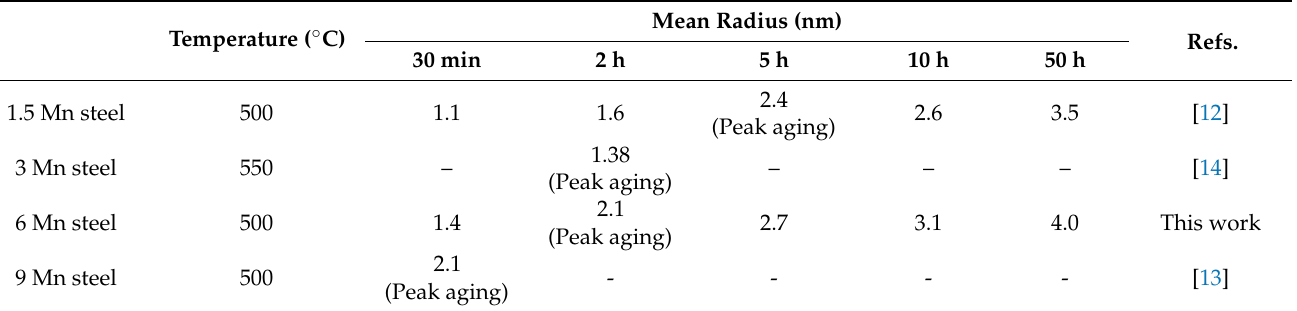
Table 3. Mean radius of nanoparticles in the 1.5 wt.%, 3 wt.%, 6 wt.%, and 9 wt.% Mn-doped steels with various aging treatment.